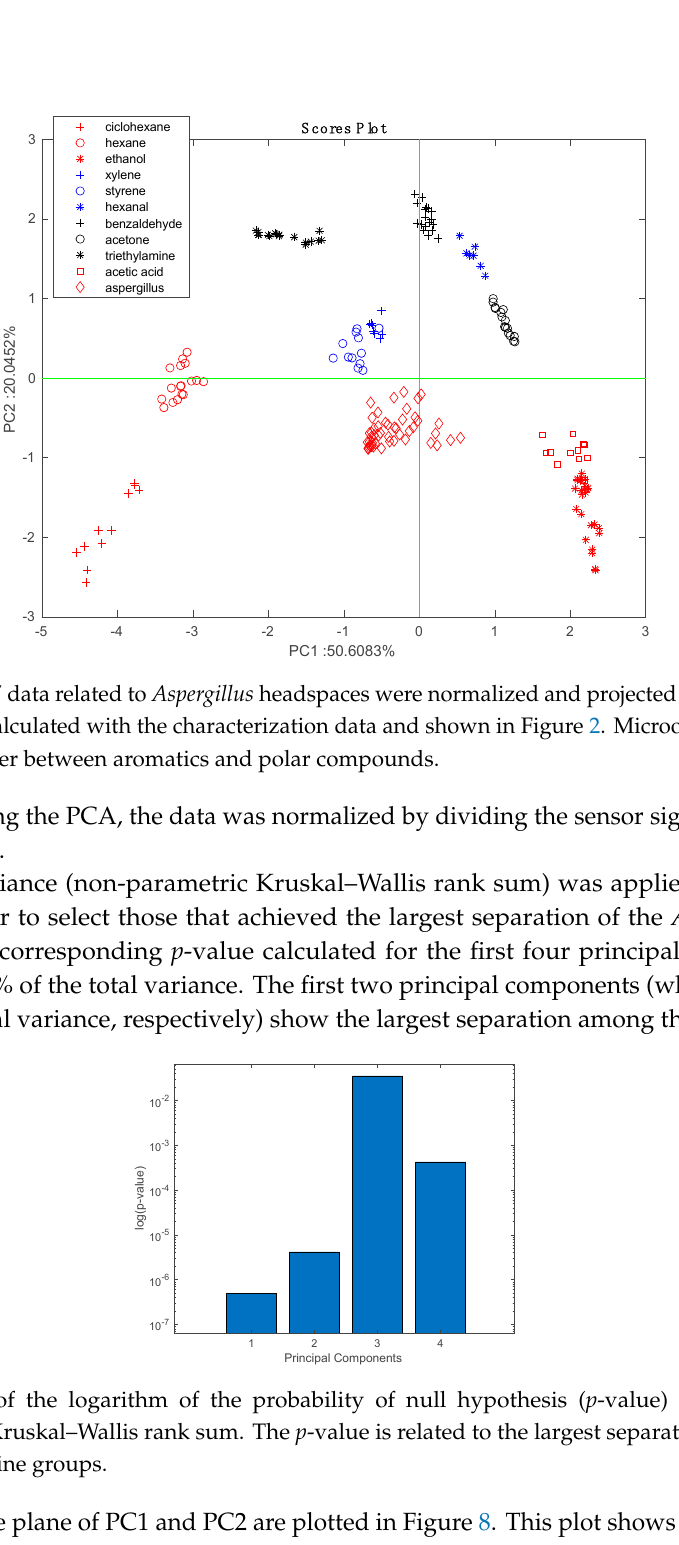
Figure 6. Sensors’ data related to Aspergillus headspaces were normalized and projected onto the scores plot of the PCA calculated with the characterization data and shown in Figure 2.